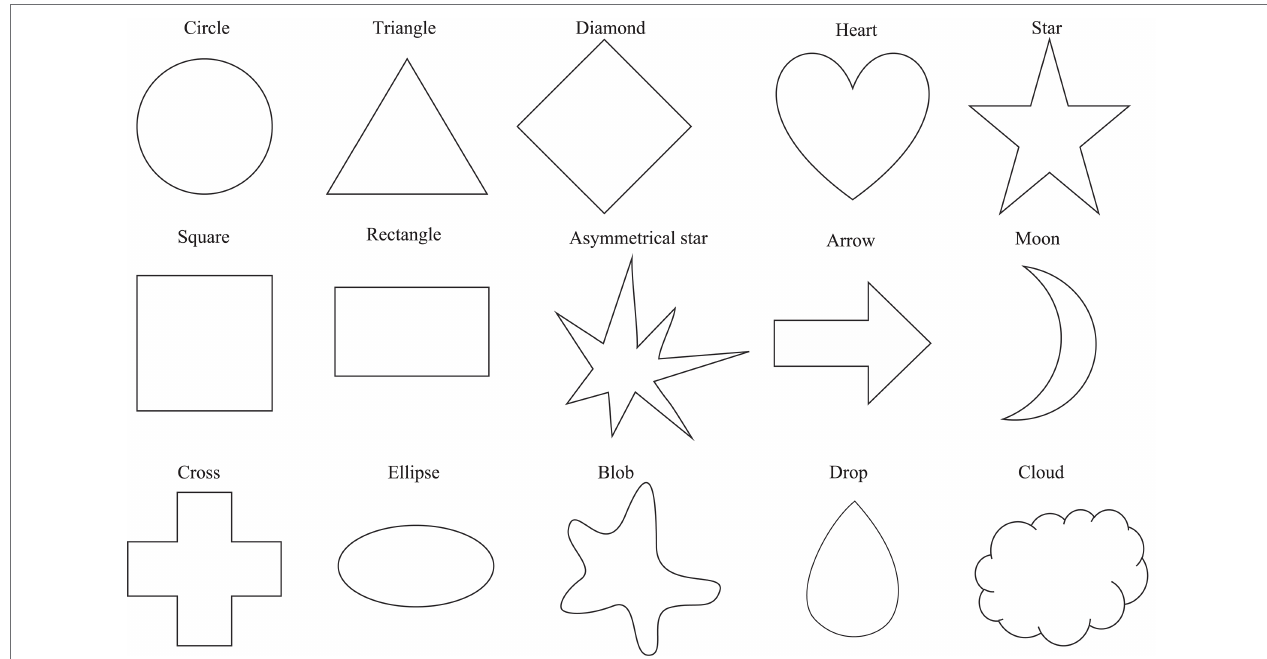
FIGURE 1 | The 15 shape stimuli used in the